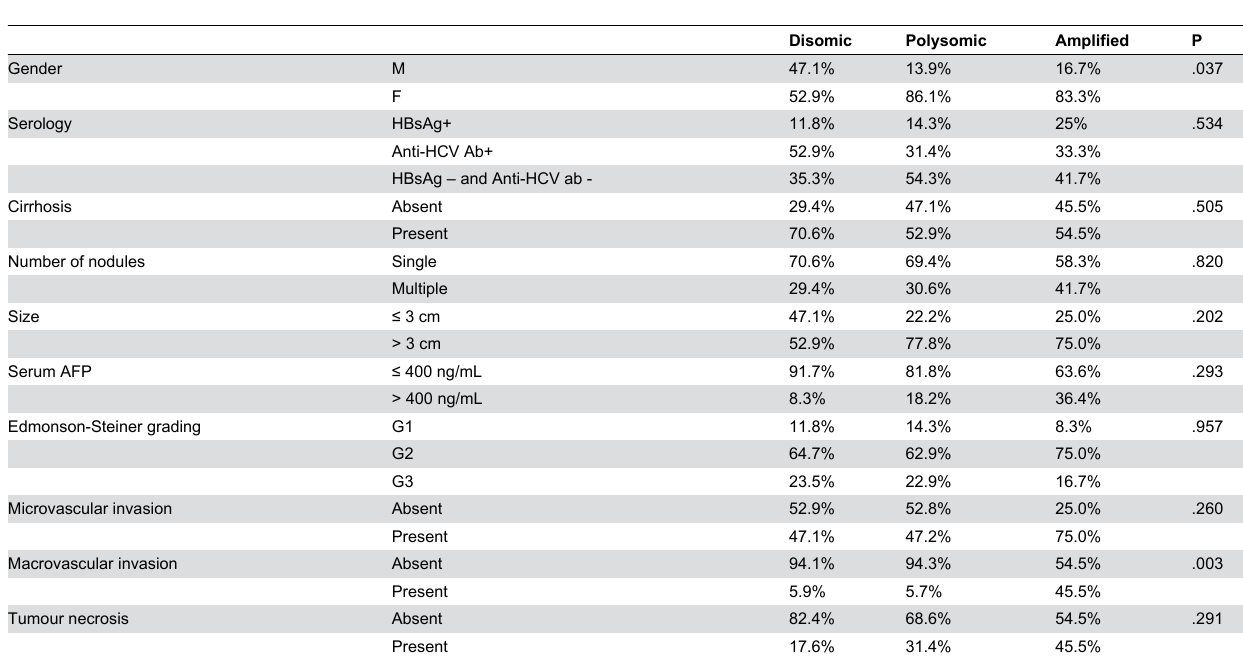
Table 2. c-myc status among different clinical and pathological features of 65 patients.